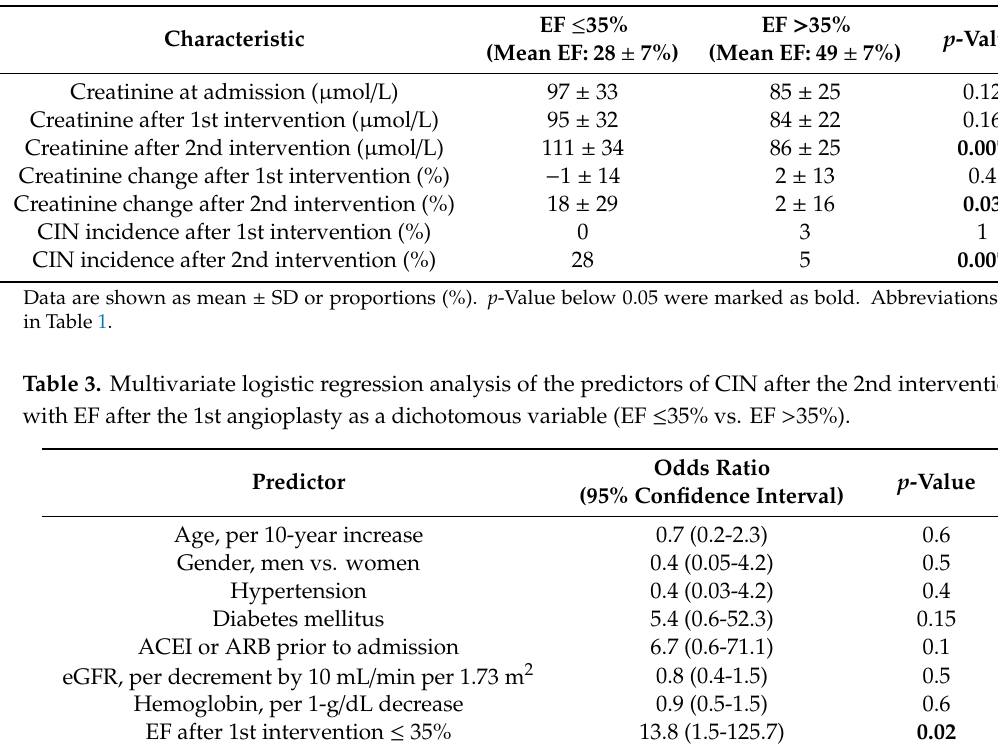
p -values below 0.05 are marked as bold. Abbreviations as in Table 1. Table 4. Multivariate logistic regression analysis of the predictors of CIN after the 2nd intervention with EF after the 1st angioplasty as a continuous